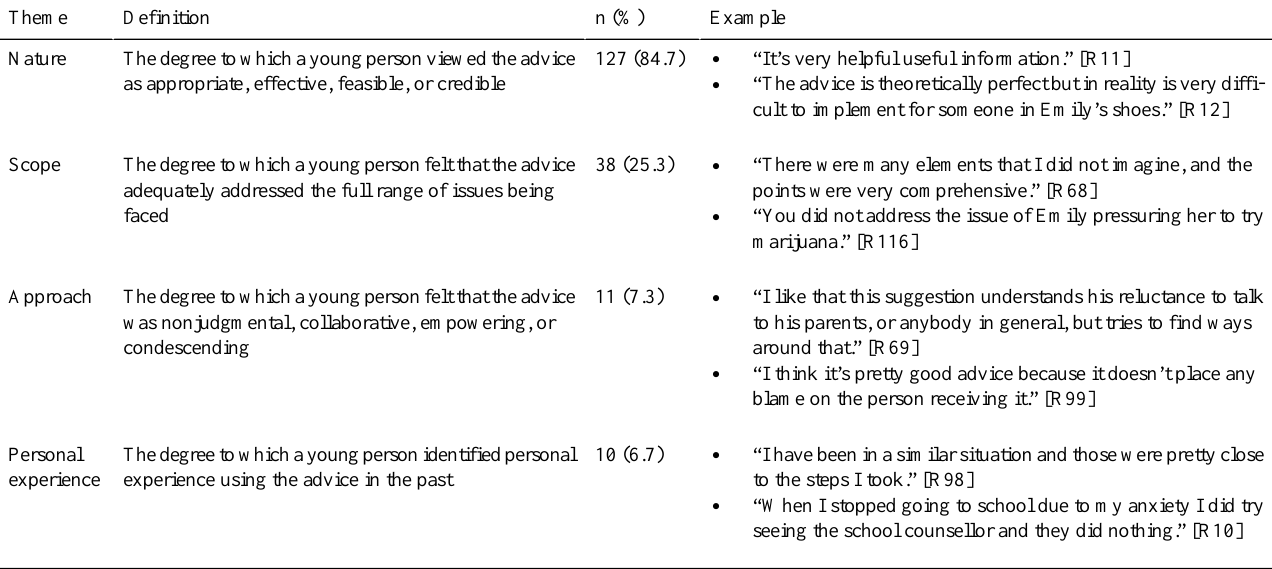
Outlined in Table 6, thematic analysis identified 4 key themes that influenced participants’ acceptability of proposed relationship-coping strategies: (1) nature, (2) scope, (3) approach, and (4) personal experience.